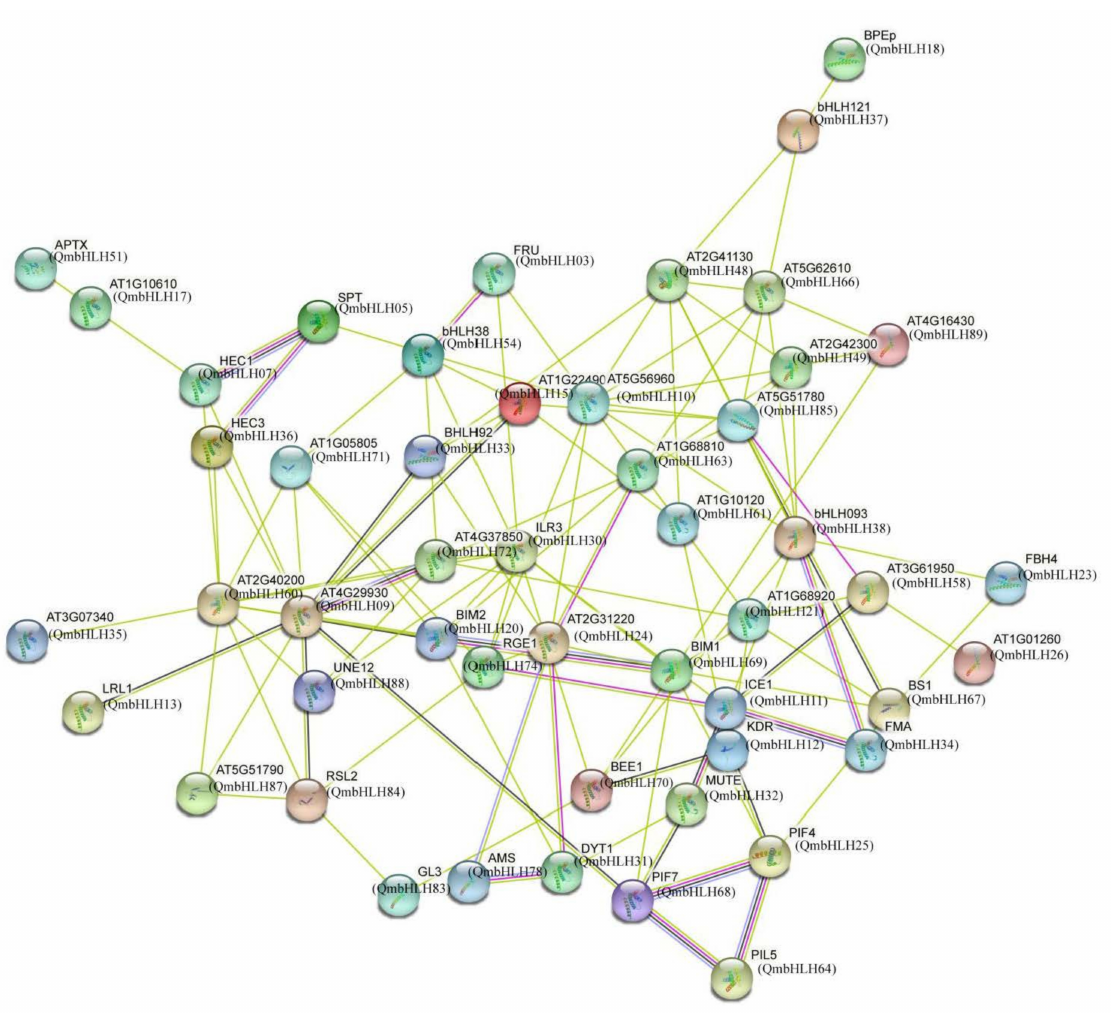
Figure 6. Protein interaction network based on orthologs of QmbHLHs in Arabidopsis . The network nodes represent proteins. The color of the lines between network nodes indicates the source of protein interaction evidence. Cyan line presents data from curated databases, purple line presents data from experimentally determined, green line gene neighborhood, red line gene fusions, blue line gene co-occurrence; yellow line presents text mining, black line co-expression, and gray line protein